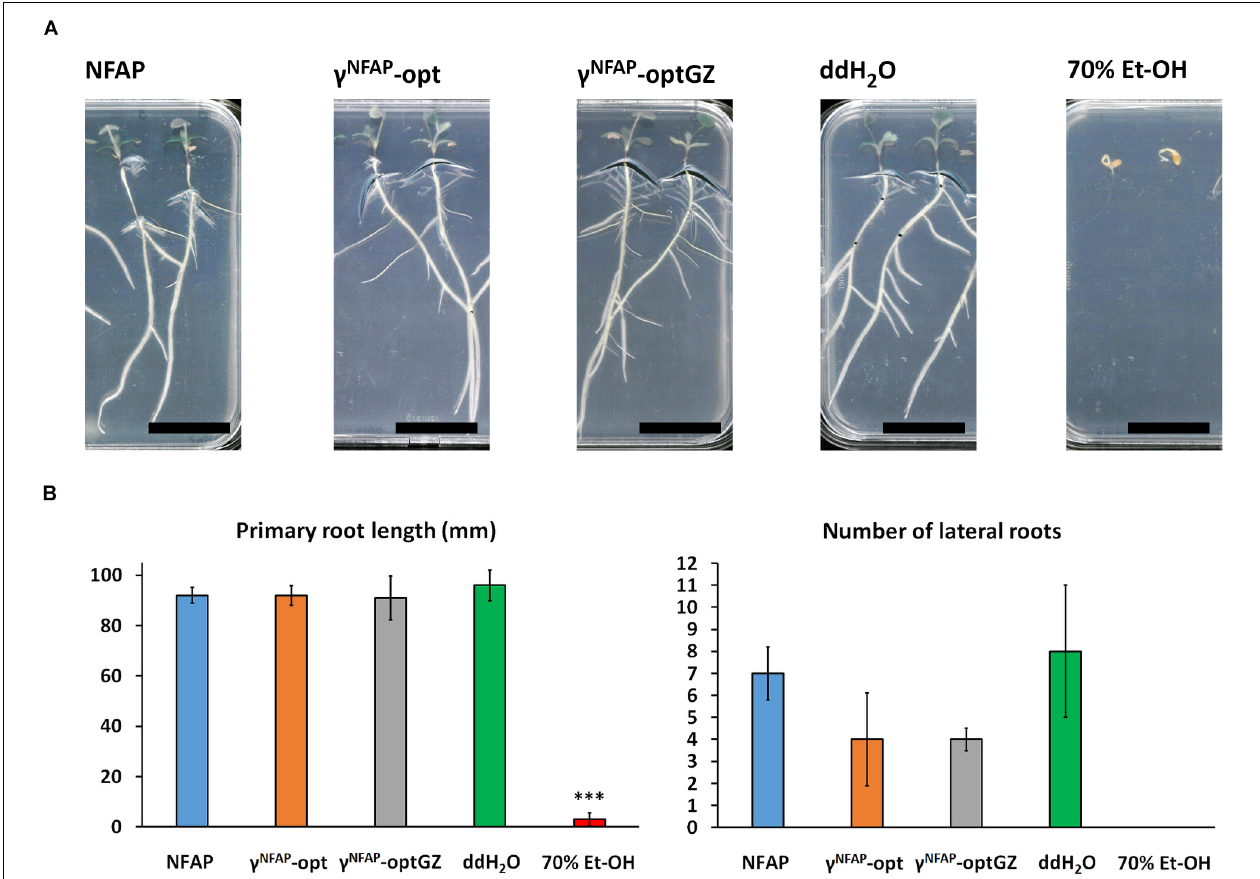
FIGURE 4 | Vegetative growth and development of Medicaco truncatula A-17 roots. (A) Phenotype of M. truncatula A-17 plants grown from seedlings and (B) the length of the evolved primary roots and number of lateral roots after treatment with 400 µ g ml − 1 Neosartorya fischeri antifungal protein (NFAP), 25 µ g ml − 1 γ NFAP -opt, and 25 µ g ml − 1 γ NFAP -optGZ peptides for 10 days at 23 ◦ C under continuous illumination of the shoot system (1200 lux) in comparison with ddH 2 O- and 70% (v/v) Et-OH-treated controls. Significant difference from two-sample t -test in (B) is indicated with ∗∗∗ ( P ≤ 0.0001) in comparison of each treatment to the ddH 2 O-treated